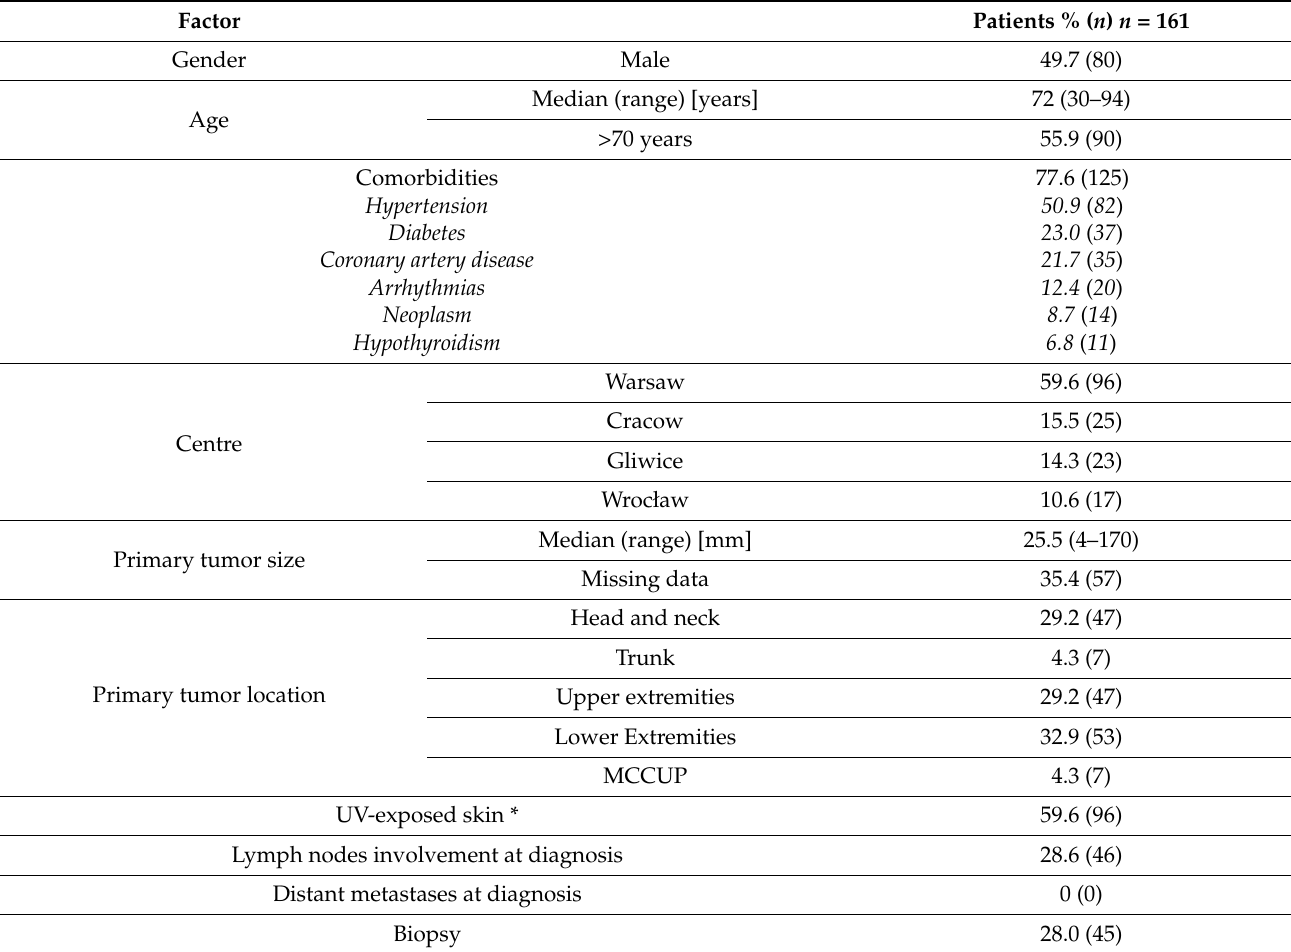
Figure 1. CONSORT flow diagram for inclusion and exclusion of cases in the study. Table 1. Demographic and clinical characteristics of the study population.